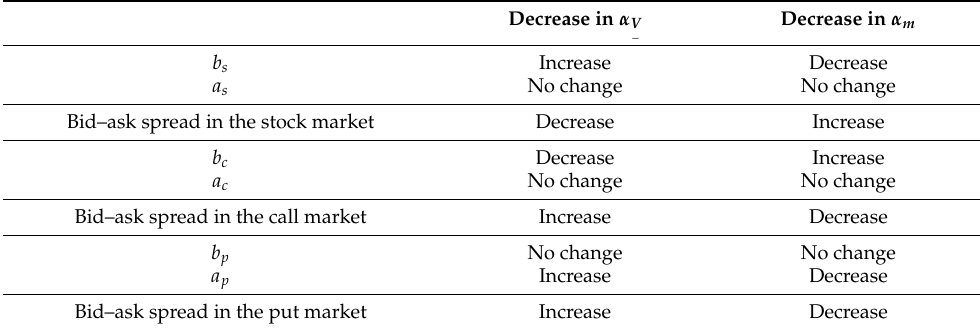
Table 1. Effects of short sales constraints on bid–ask